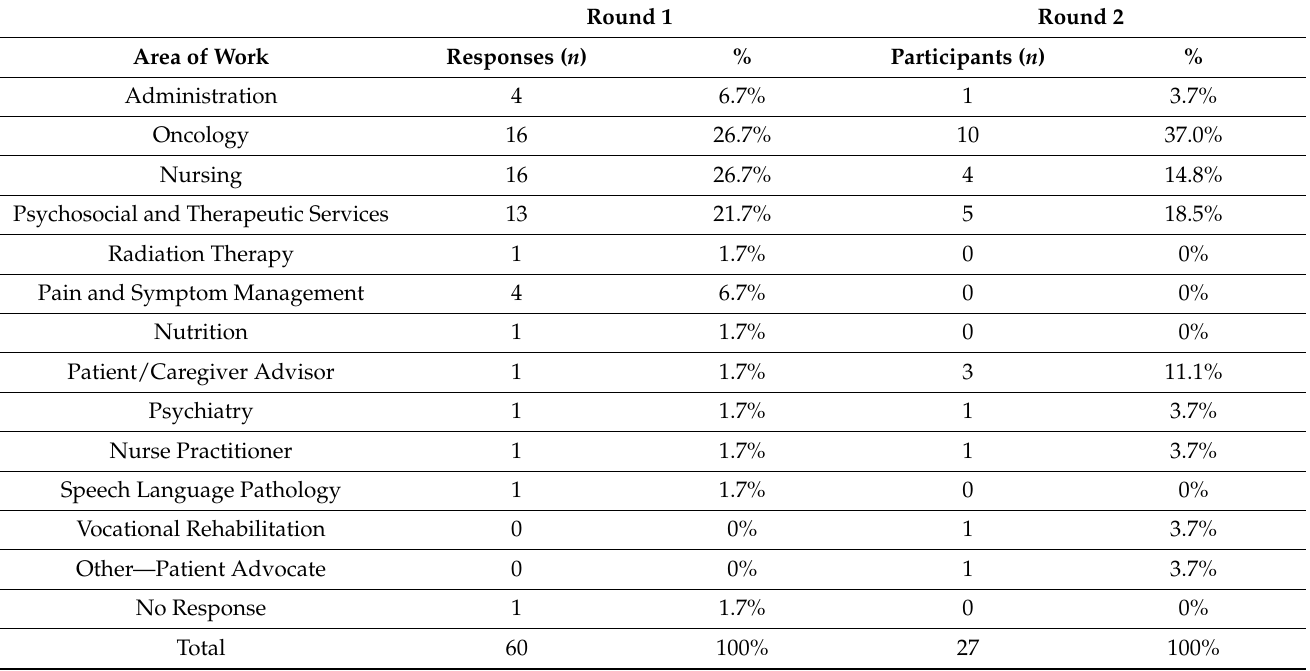
Table A1. Delphi survey respondent and engagement session participant areas of